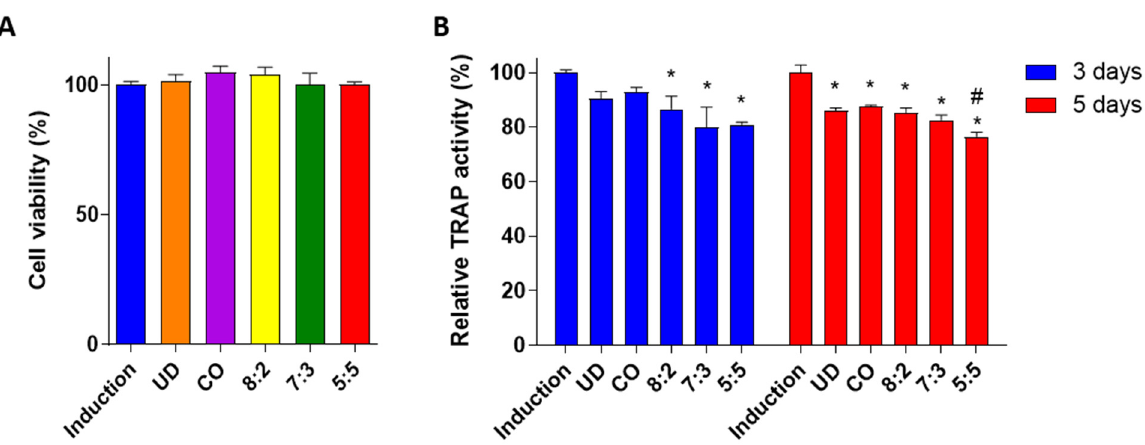
Figure 4. Effects of Ulmus davidiana (UD) and Cornus officinalis (CO) extract on osteoclast activity. Primary monocytes were co-treated with an osteoclast induction medium and 10 μ g/mL of UD, CO extract or their combination (8:2, 7:3 and 5:5). After 5 days of induction, ( A ) cell viability and ( B ) TRAP activity were evaluated. The results on the bar-graph are from three independent experi- ments. UD, Ulmus davidiana treatment; CO, Cornus officinalis treatment; * p < 0.05 vs. induction; # p < 0.05 vs. 8:2 (one-way ANOVA with Tukey’s multiple comparison test).